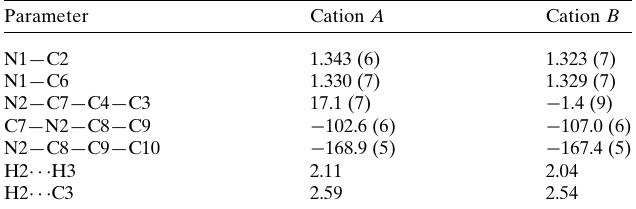
Table 1 Some geometrical characteristics (A˚ , (cid:5) ) of cations A and B in AmBr hemihydrate.